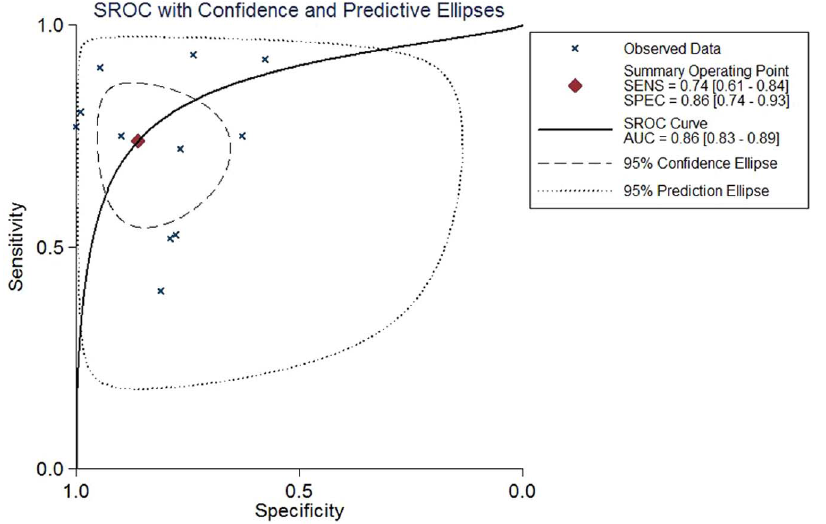
Figure 4. Hierarchical summary receiver perating characteristic (SROC) plots of urine kidney injury molecule 1 level to predict acute kidney injury across all settings. The curve is represented by the straight line; each of the analyzed studies is represented by a circle; the point estimate to which summary sensitivity (SENS) and specificity (SPEC) correspond is represented by the diamond shape, and the respective 95% confidence intervals, by the dashed line, whereas the 95% confidence area in which a new study will be located is represented by the dotted line. Abbreviation: AUC, area under the curve.